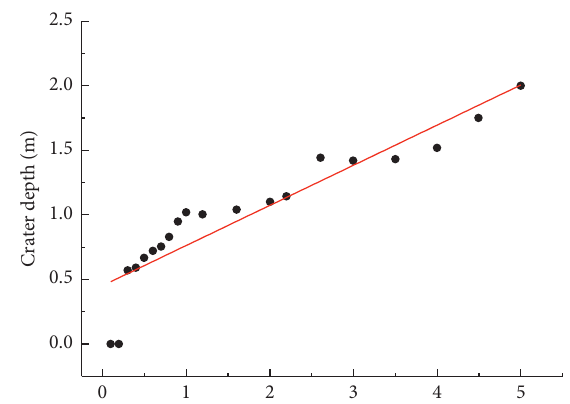
Figure 2: Peak pressure action coefficient – the depth of blasting crater.